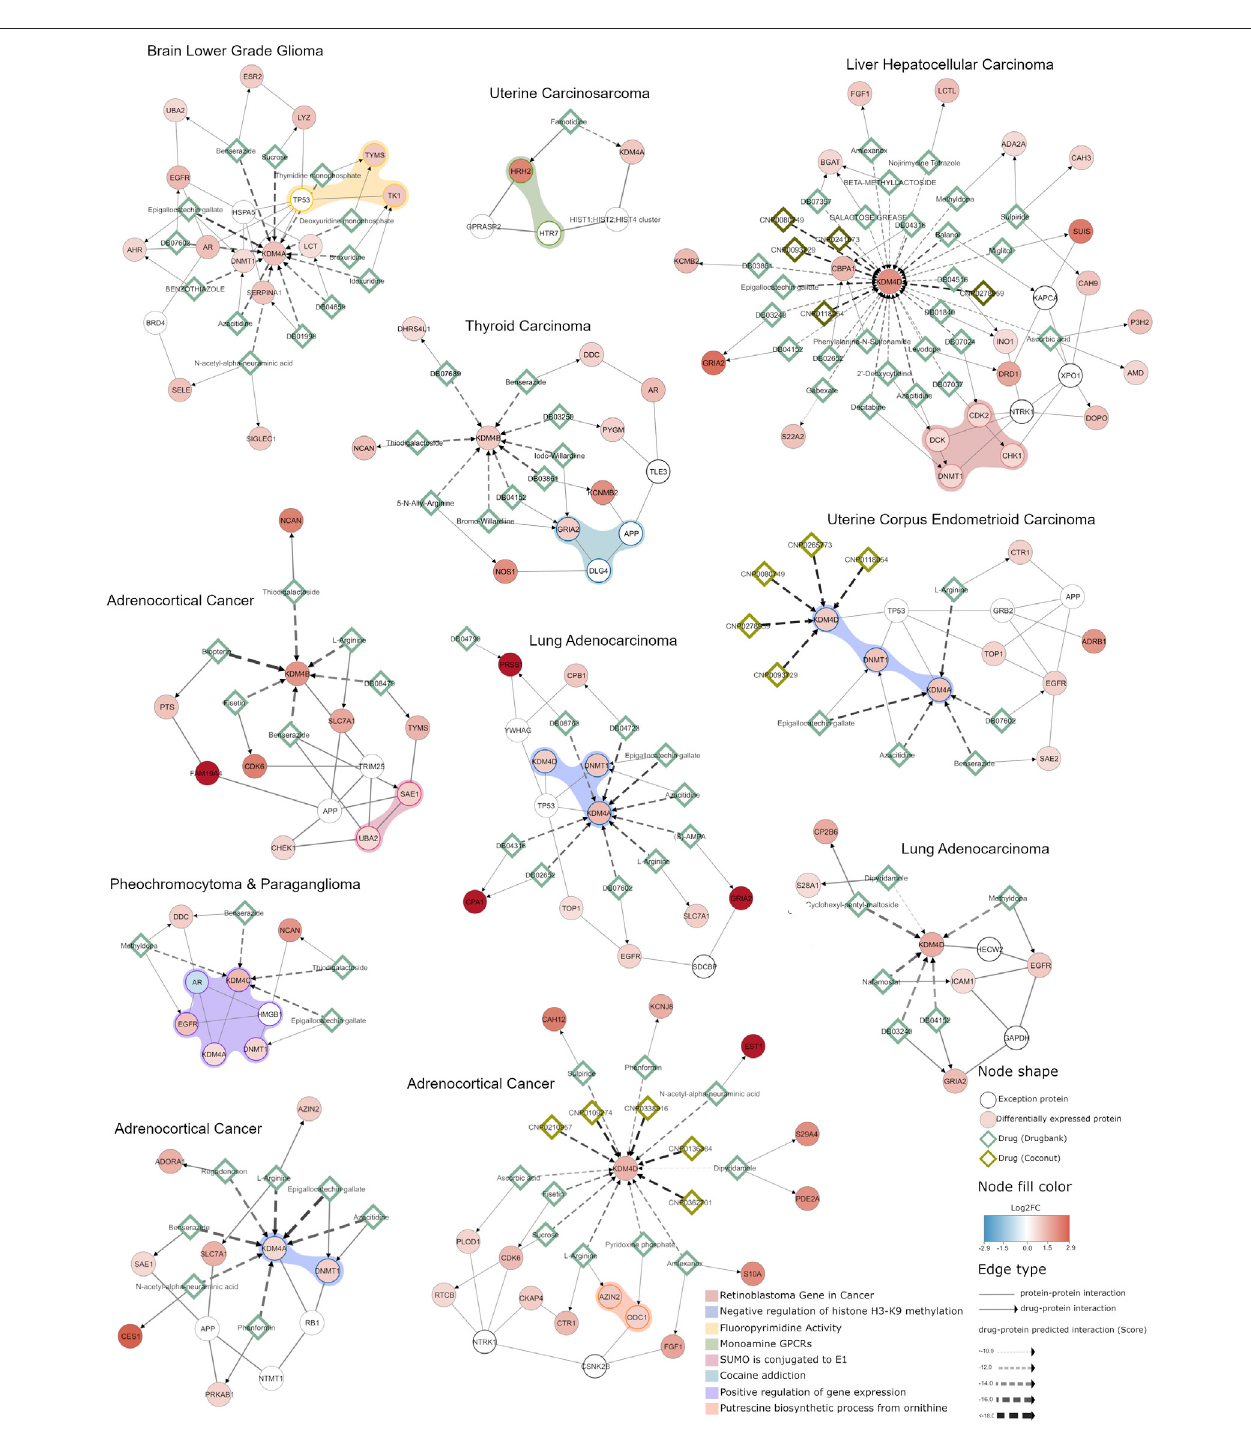
FIGURE7| IntegrativenetworkanalysisofKDM4potentialinhibitorsindifferentcancertypes.Anetworkenrichedwithdifferentiallyexpressedgenesobtainedfrom each cancertype selected isshown.The circular nodes represent proteins, and theedgestheinteractionsbetweenthem. The colorofthe circular nodes representsthe foldchangeingeneexpressionbetweentumorswithhighandlowKDM4expression.Drugstargetingtheproteinsarerepresentedbydiamondnodes,wheredarkgreen is used for Drugbank drugs and light green for natural compounds (Coconut database). The Drugbank drug and protein target interactions were retrieved from curated databases (NeDRex platform), while the natural compound interactions with proteins are predicted by the in silico analysis performed previously. The colored shadow highlights the proteins that participate in a cellular process according to g.Pro fi ler enrichment. Overall, the network depicts the KDM4 proteins, their protein interaction context and shared interactions with known drugs and natural compounds.